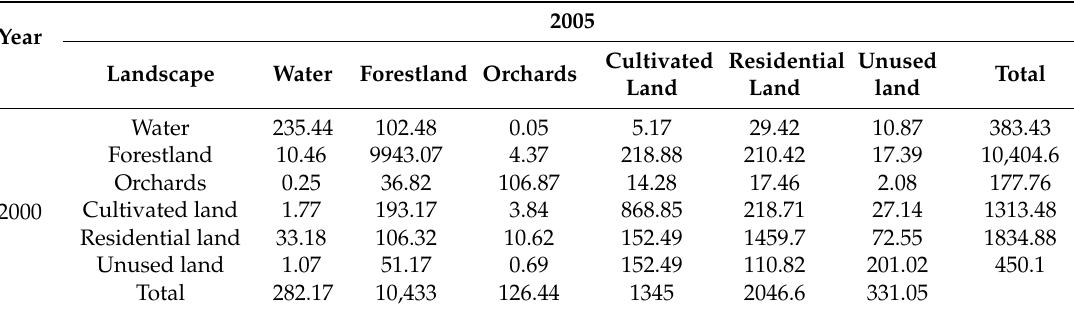
Table 20. The landscape transition matrix from 2000 to 2005 (km 2 ).